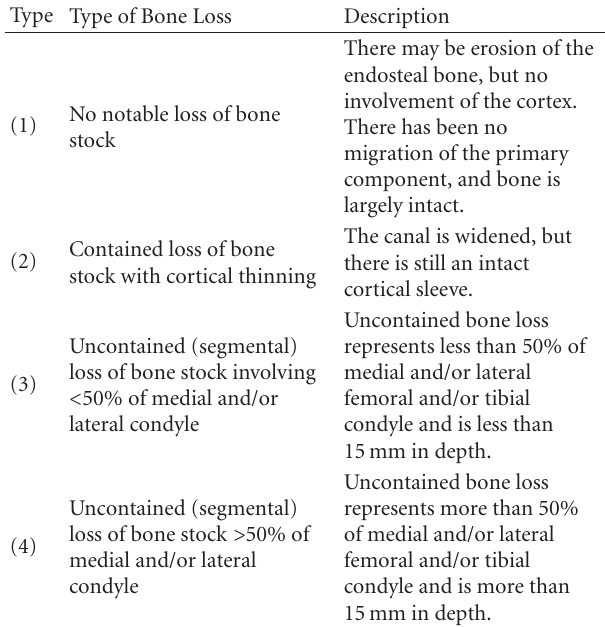
Table 2: Classification of Tibial and Femoral Bone Loss